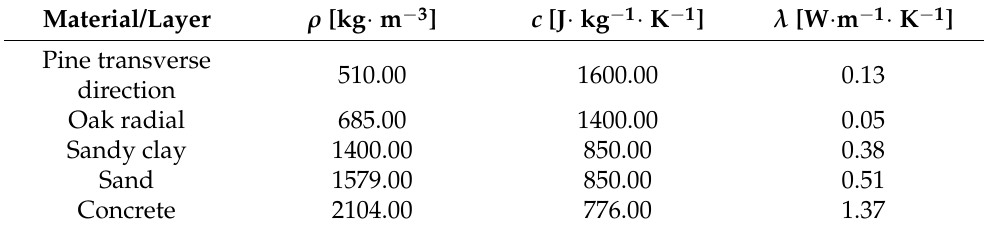
Table 1. Physical parameters of materials implemented in the computational